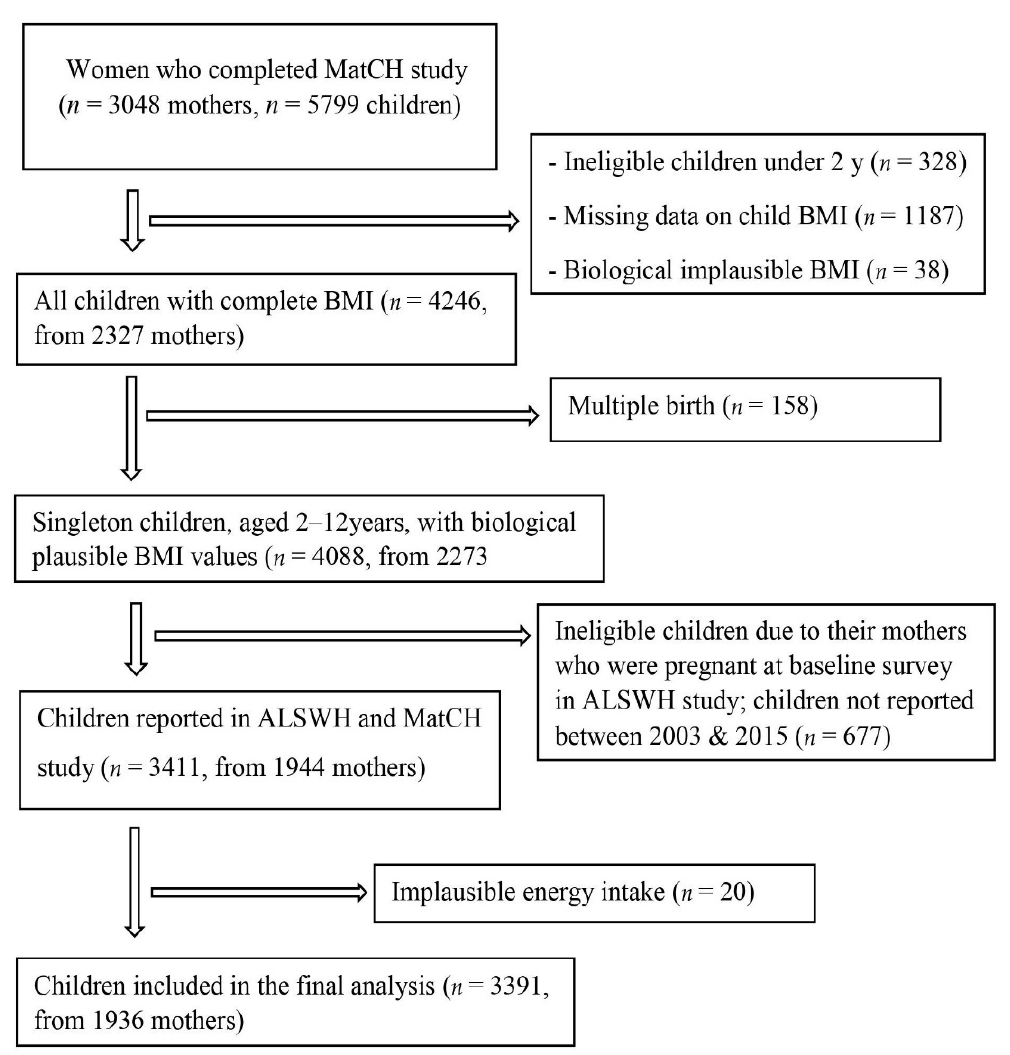
Figure 1. Flow diagram of the study sample from the Australian Longitudinal Study on Women’s Health (ALSWH) and Mothers and their Children’s Health (MatCH) study for the analysis of relationship between preconception dietary patterns and childhood body mass index (BMI).